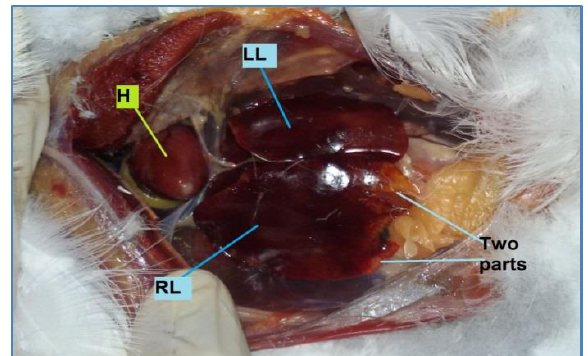
Figure, 3: Shows the location and shape of the liver in gull. The left lobe (LL), Right lobe (RL) which contains two parts, and presence the heart